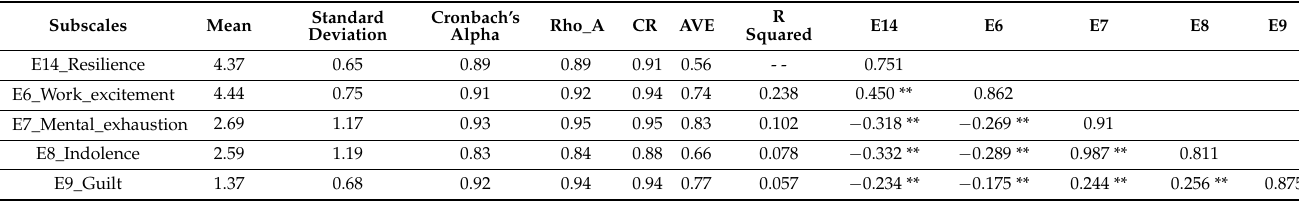
Table 4. Descriptive statistics, reliability and validity of